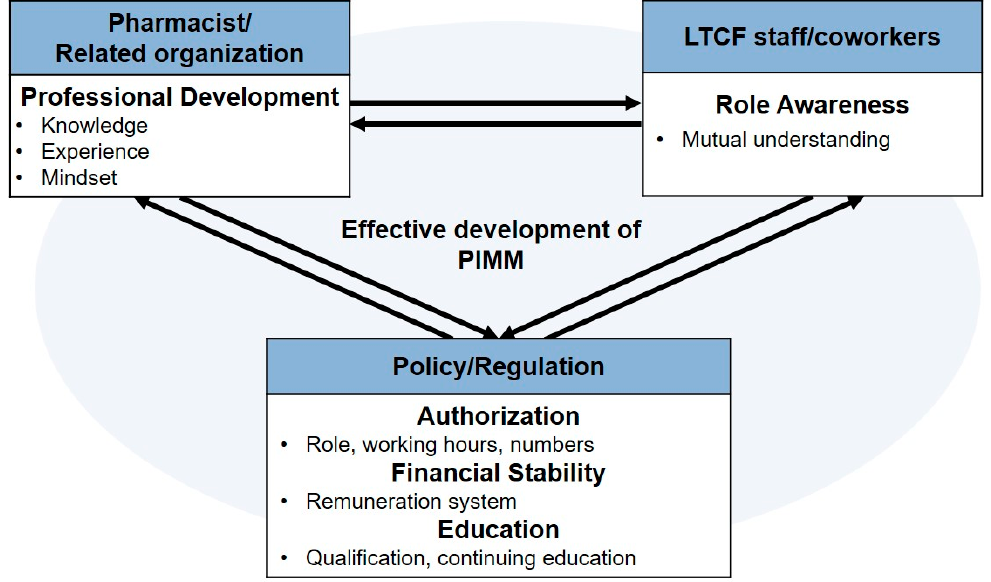
Figure 1. Essential elements and their interactions for the effective development of pharmacist-involved medication management (PIMM).